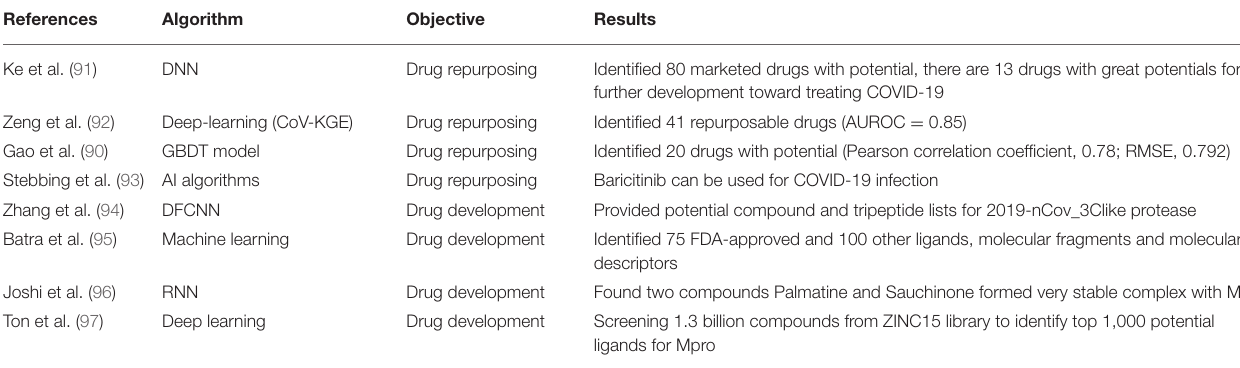
TABLE 6 | Application of AI in drug discovery of